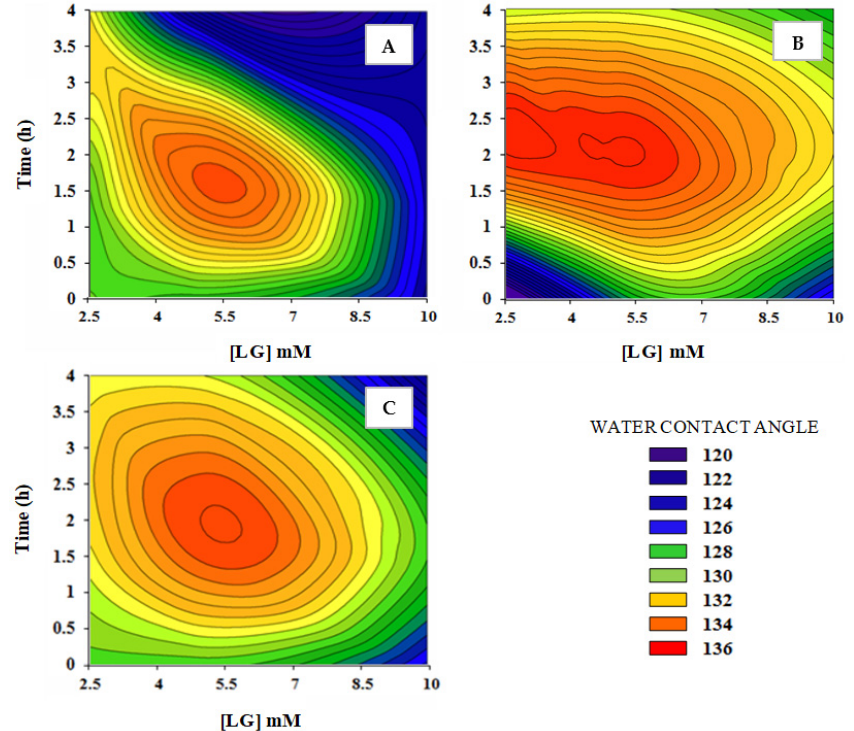
Figure 1. Water contact angle values after one second of drop deposition of the hydrophobized beech veneers as a function of time of reaction and lauryl gallate concentration. Laccase dose: 3.36 U/cm 2 wood ( A ); 5.00 U/cm 2 wood ( B ); 6.72 U/cm 2 wood ( C ).